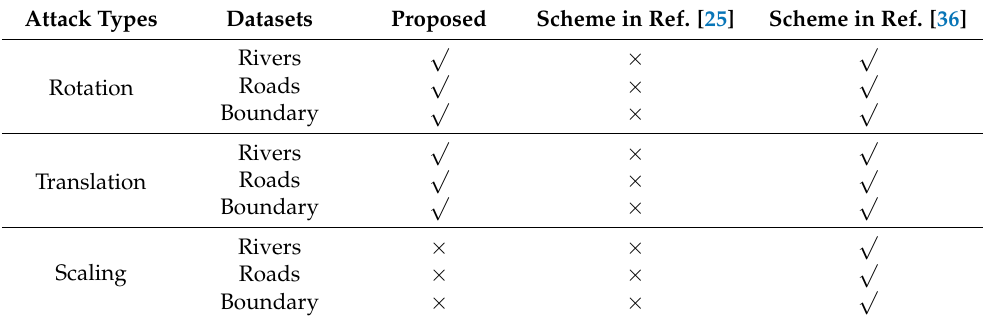
Table 6. Comparison between the proposed scheme and prior